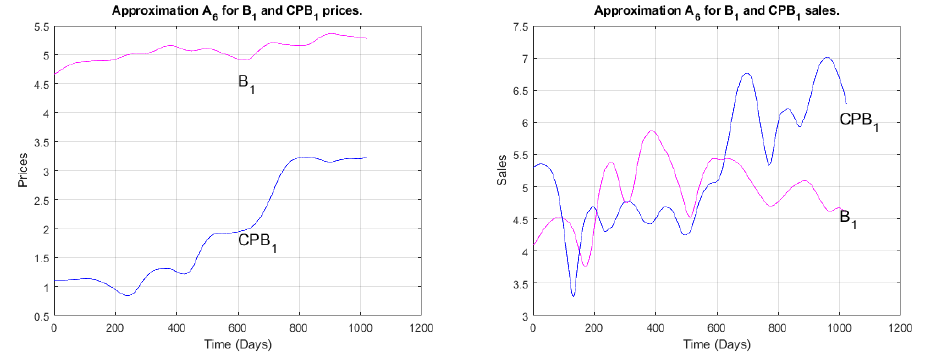
Figure 13. The wavelet approximation A 6 for B 1 and CPB 1 prices and sales at level 6.